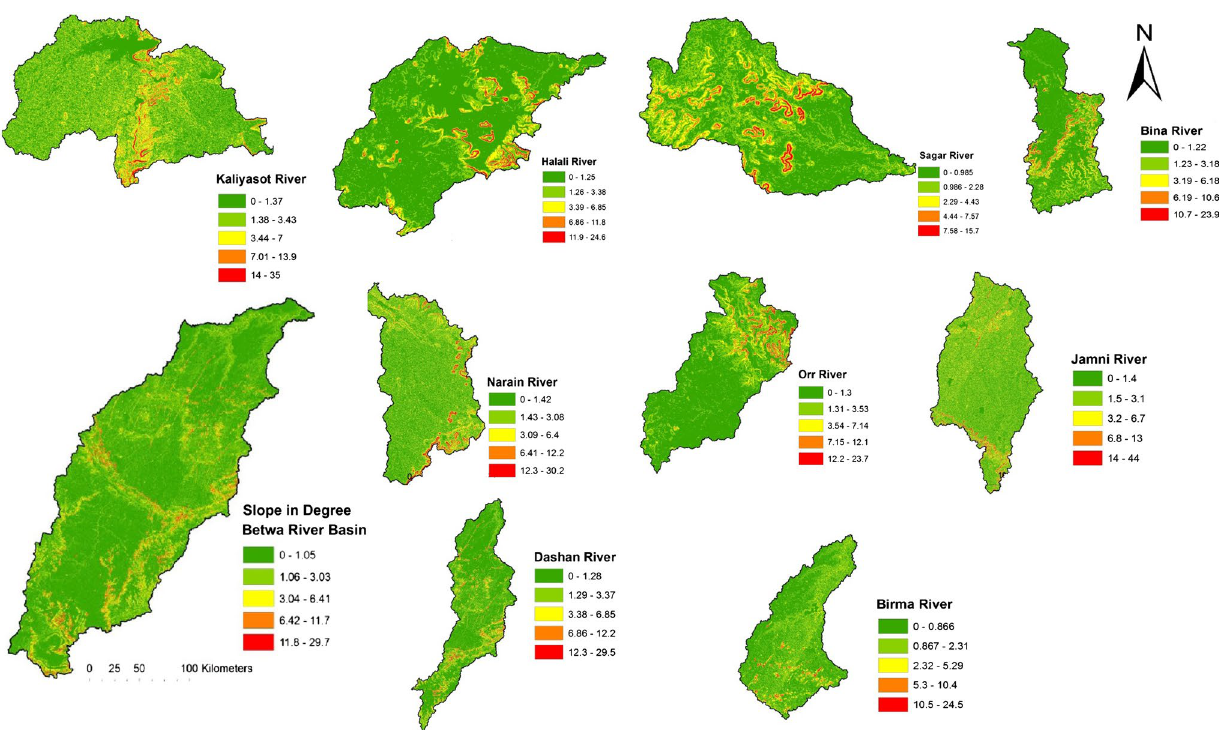
Fig. 6 Slope map of the Betwa River basin and sub-basins